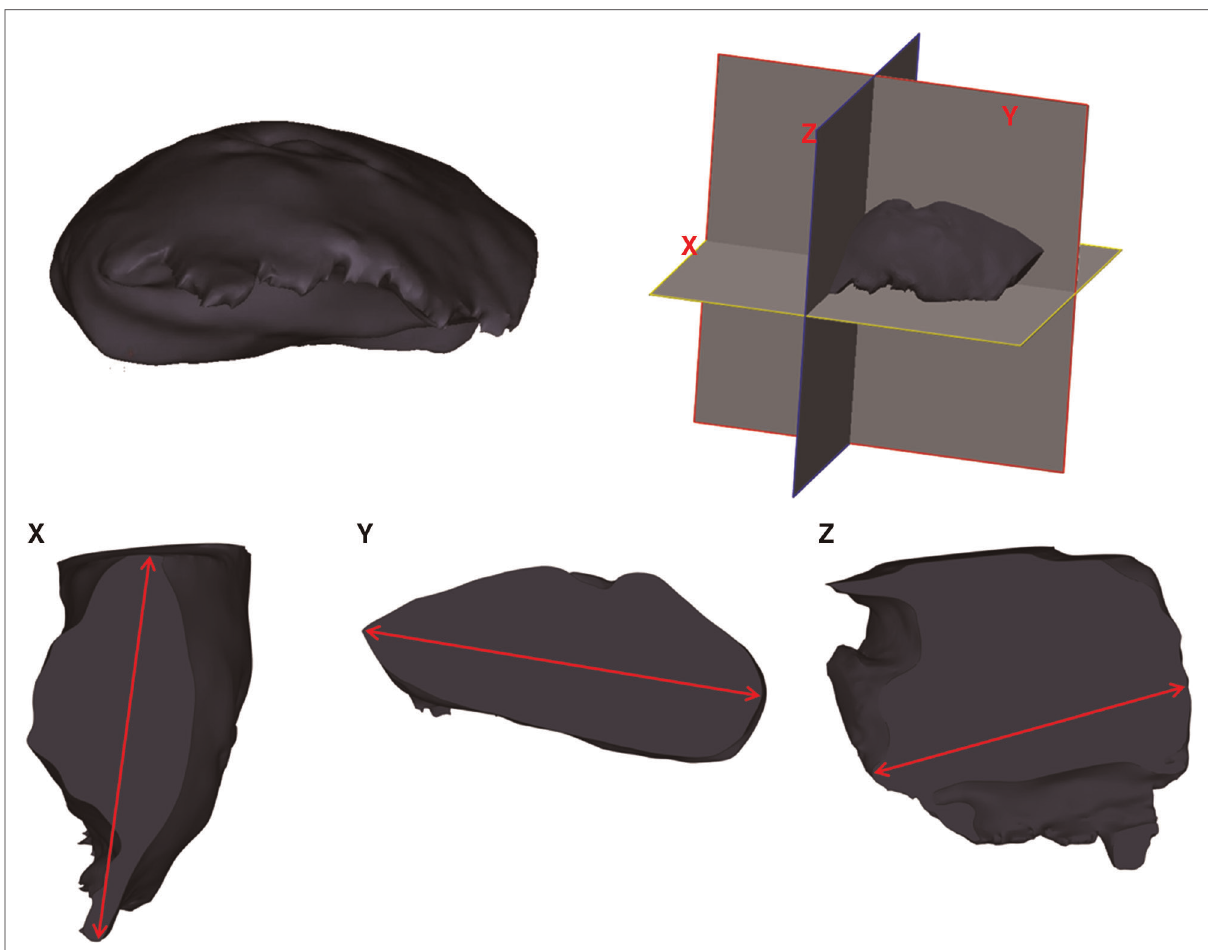
FIGURE 2 Diagram demonstrating the measurement of tumor size on 3DR models and surgical resected